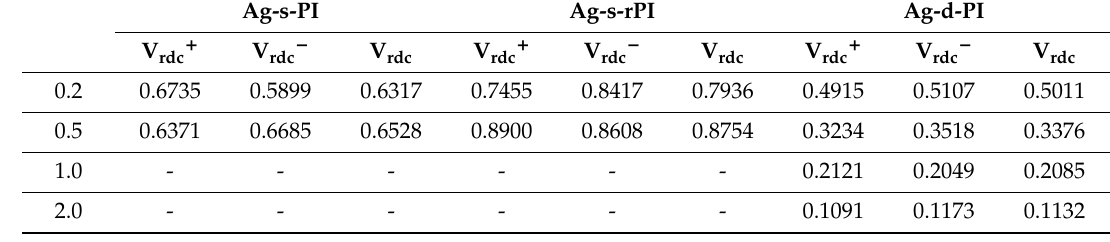
Table 1. V rdc of cells assembled with Ag / PI composite alignment layers.